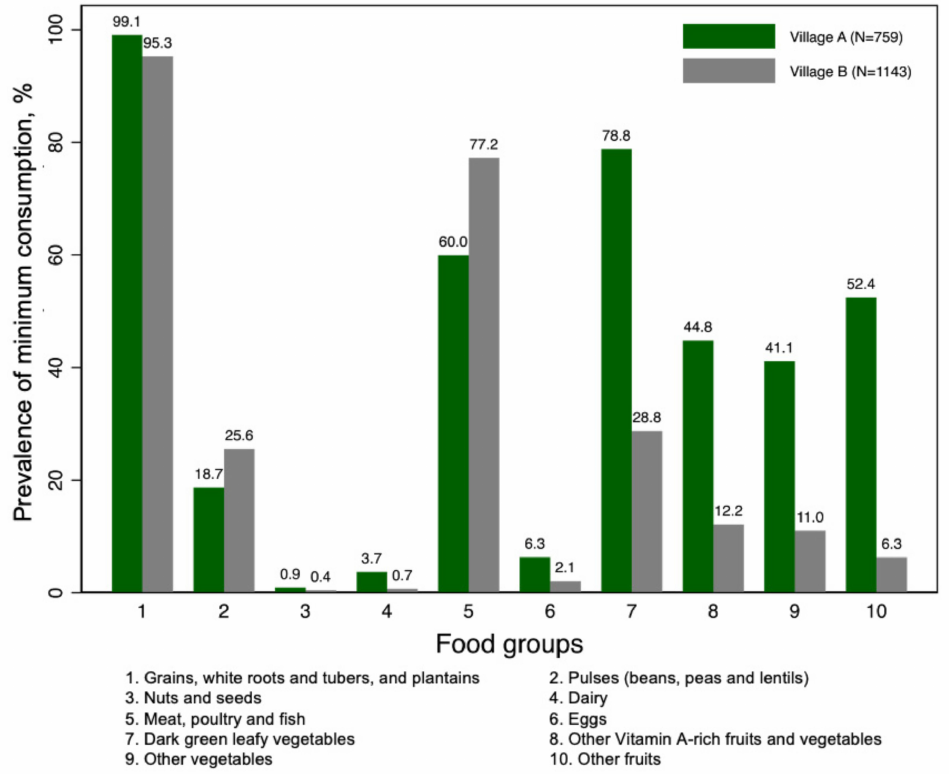
Figure 1. Prevalence of minimum consumption of food groups in children in two villages in western Kenya. Minimum consumption is defined as food group intake ≥ 15